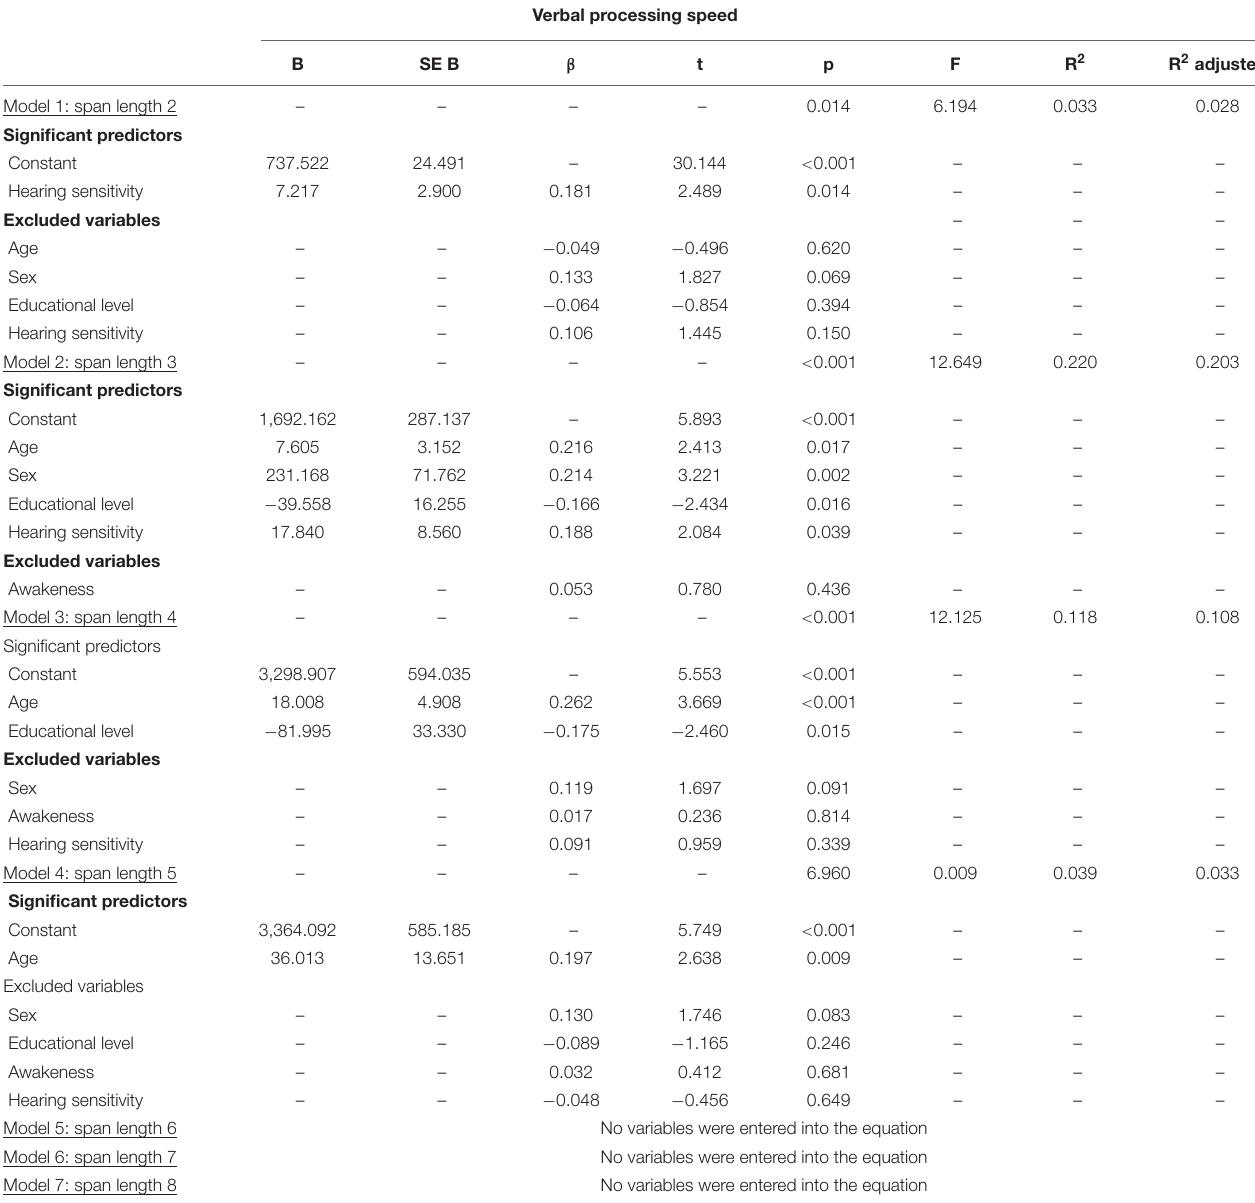
TABLE 9 | Stepwise multiple regression with age, sex, educational level, awakeness, and hearing sensitivity as independent variables and verbal processing speed at each span length as dependent